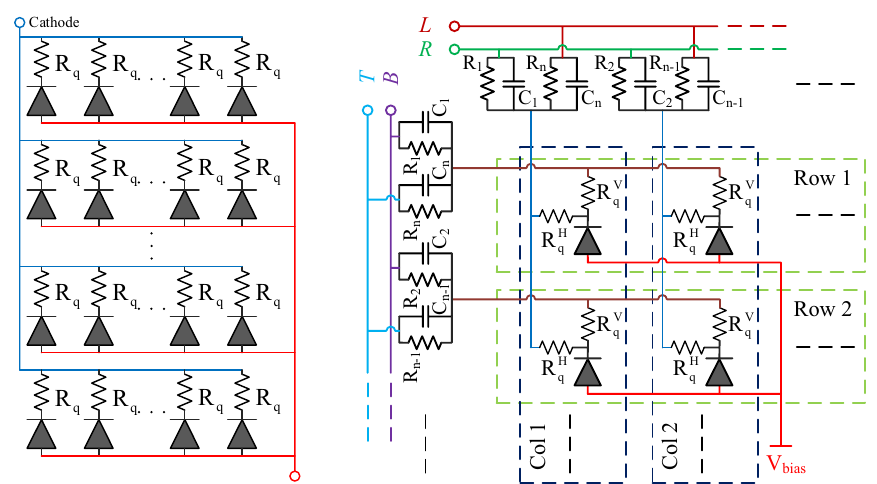
Fig. 9 Schematics of (left) non-PS-SiPM and (right) linearly-graded SiPM (LG-SiPM). LG-SiPM is a type of PS-SiPM [52]